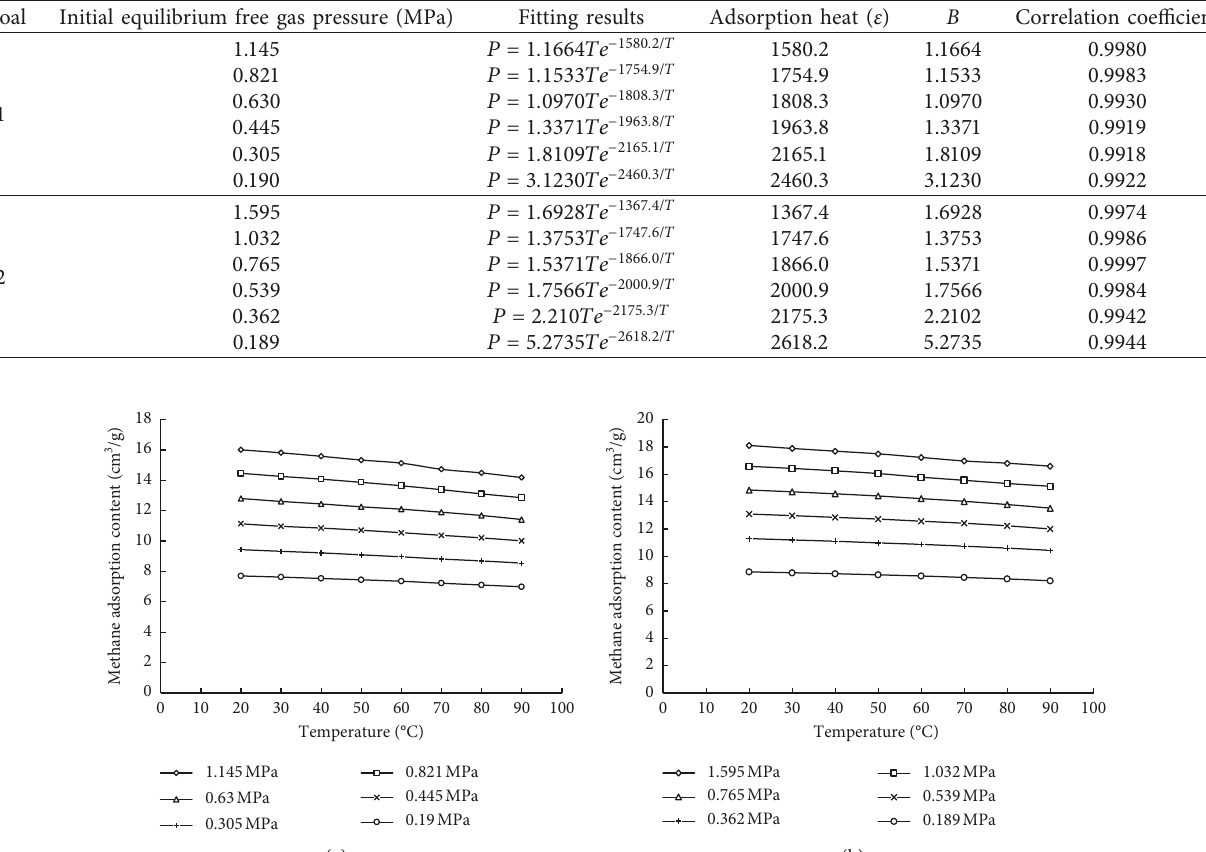
Figure 3: The Equilibrium pressure with different initial free gas content at different temperatures. (a) #1 coal; (b) #2 Table 3: Fitting results of equation (5).